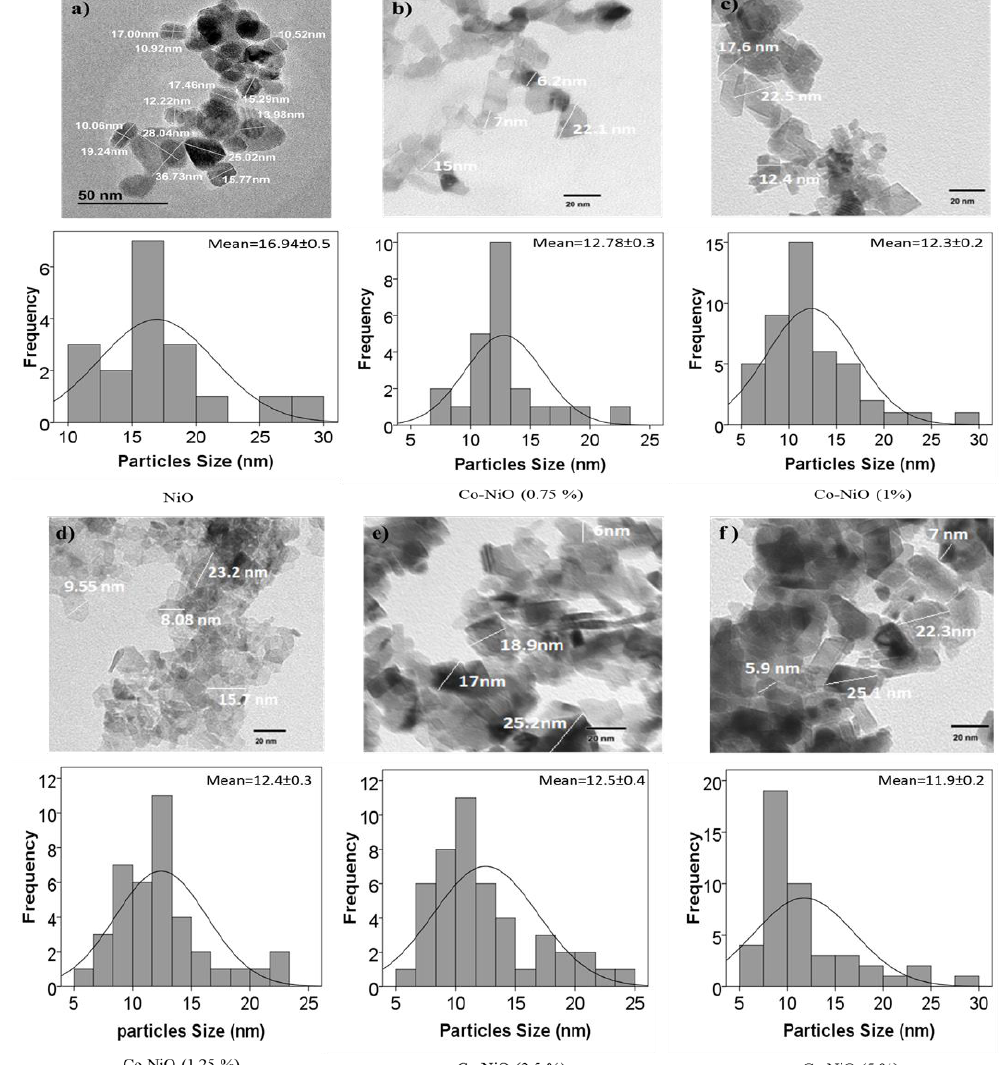
Figure 2. Transmission electron microscopy (TEM) images and relative histograms of the nanoparticles size distributions of ( a ) NiO x nanoparticles; ( b ) 0.75 mol% Co-NiO x nanoparticles; ( c ) 1 mol% Co-NiO x nanoparticles; ( d ) 1.25 mol% Co-NiO x nanoparticles; ( e ) 2.5 mol% Co-NiO x nanoparticles; ( f ) 5 mol% Co-NiO x nanoparticles. XRD peaks of all samples correspond to the standard pattern characteristic of the cubic crystal structure of NiO x , with three characteristic diffraction peaks at 37.1°, 43.0° and 62.7° related to (111), (200) and (220) planes of NiO x , respectively (Figure 3a). No secondary phase is detected, ruling out the formation of other Co-based structures such as CoO. Therefore, the NiO x has been formed with relatively high phase purity and, according to the difference in the peaks intensities between the samples of undoped NiO x and Co-doped NiO x , it is clear that Ni ions have been successfully replaced with Co ions, as demonstrated also by energy-dispersive X-ray spectroscopy (EDS) measurements (Figure S1) [39]. We investigated the optical characteristics of the pristine NiO x and Co-NiO x films. The Co-NiO x films deposited on the ITO substrates revealed a high transmission (>87%) in the visible